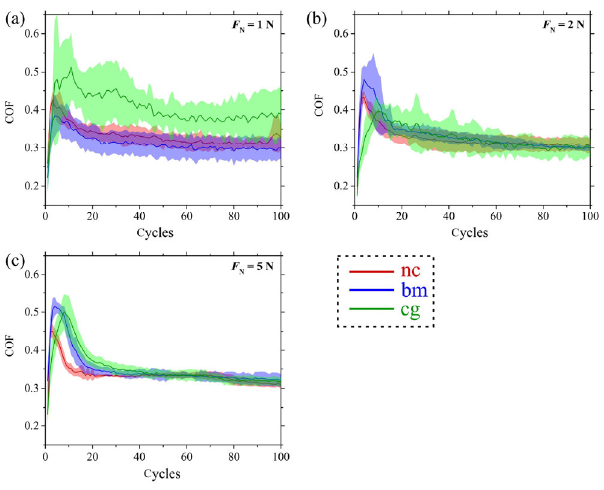
Fig. 2 Short-term evolution of the coefficient of friction (COF) tested at (a) 1 N, (b) 2 N, and (c) 5 N of normal load. The shaded areas represent the standard deviation of the